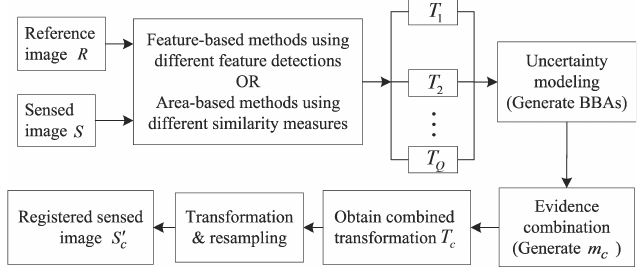
Figure 4. Flow chart of the proposed image registration.